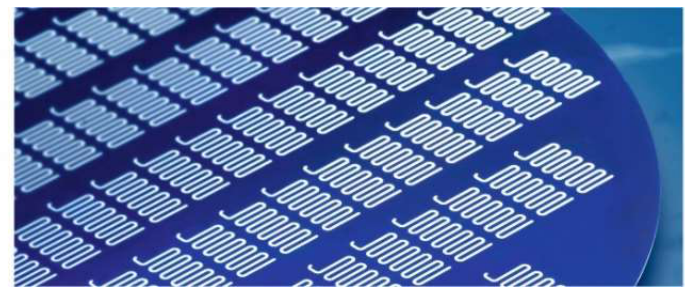
Figure 18. Silicon substrate with 20 mm long, meander-type porous 3D microstructures, agglomerated from monodisperse oxidized Si beads with a mean size of 10 µm using 75 nm ALD-Al 2 O 3 . A close-up of a 3D microstructure agglomerated from Si beads is provided in Figure